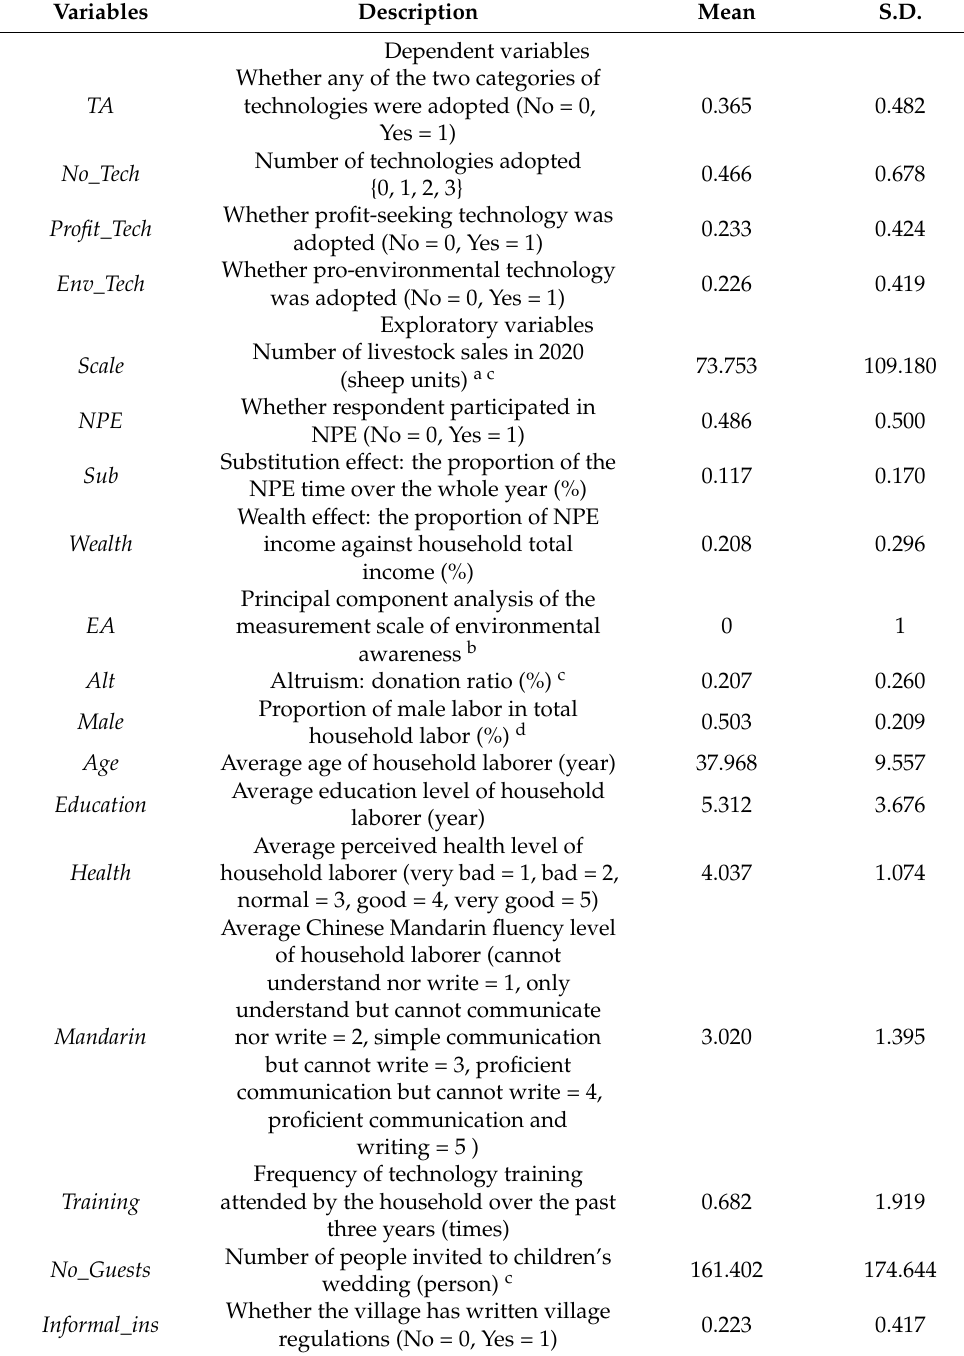
Table 1. Variable definitions and descriptive